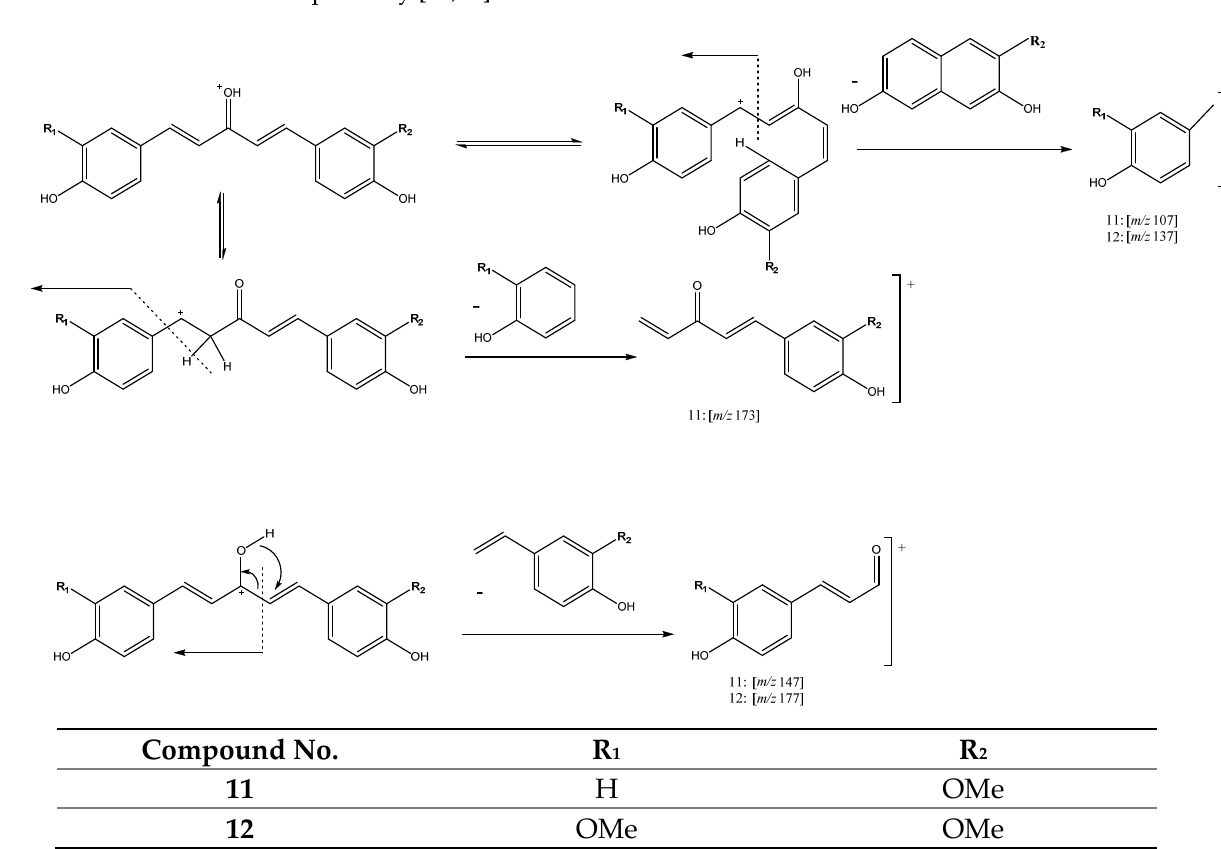
Figure 8. Fragmentation pathways I and II for compounds 11 and 12